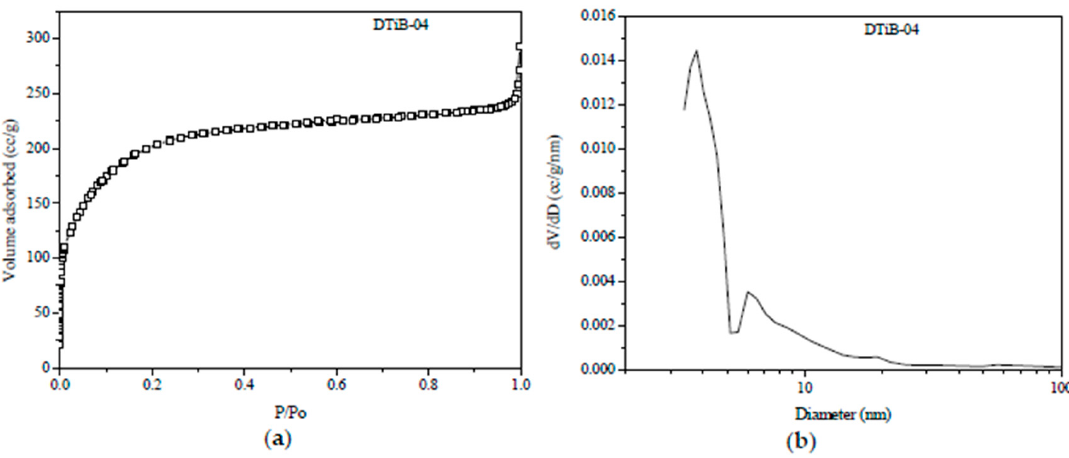
Figure 4. ( a ) N 2 adsorption-desorption plot for the DTiB-04 isotherm; ( b ) Pore size distribution curve for the same DTiB-04 sample obtained from the desorption isotherm.